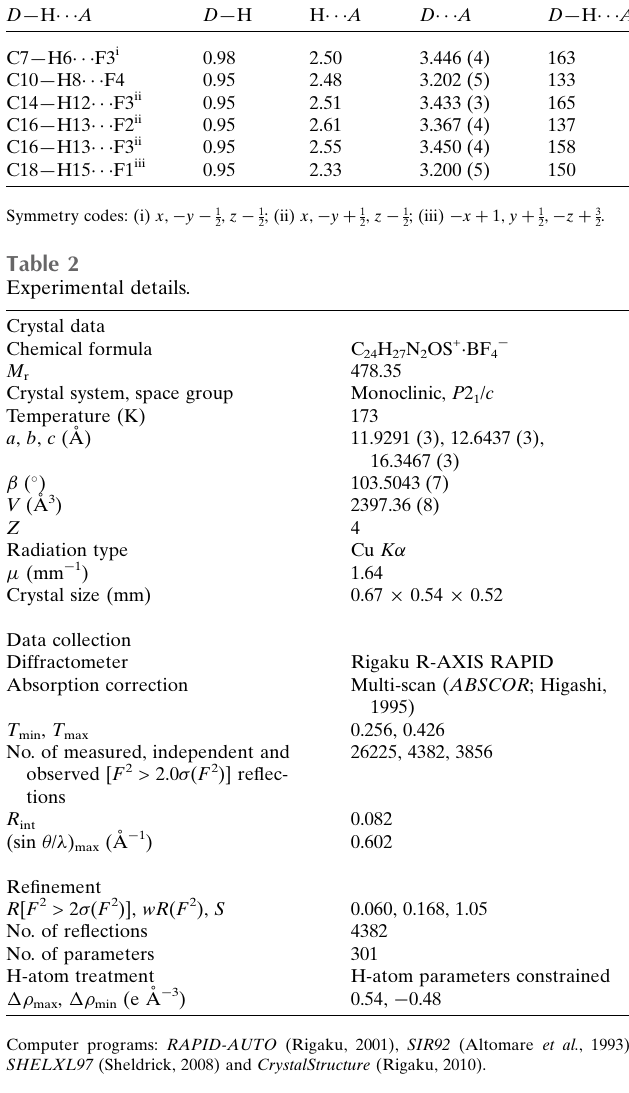
Table 1 Hydrogen-bond geometry (A˚ , (cid:4) ).